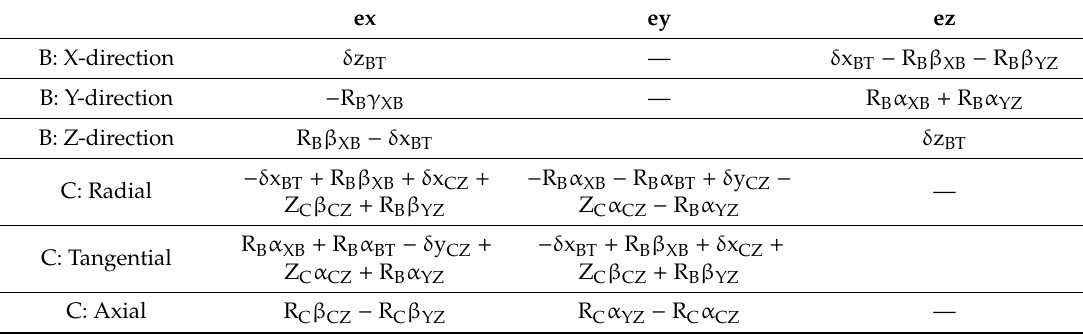
Table 5. Mathematical expressions between eccentricities and geometric